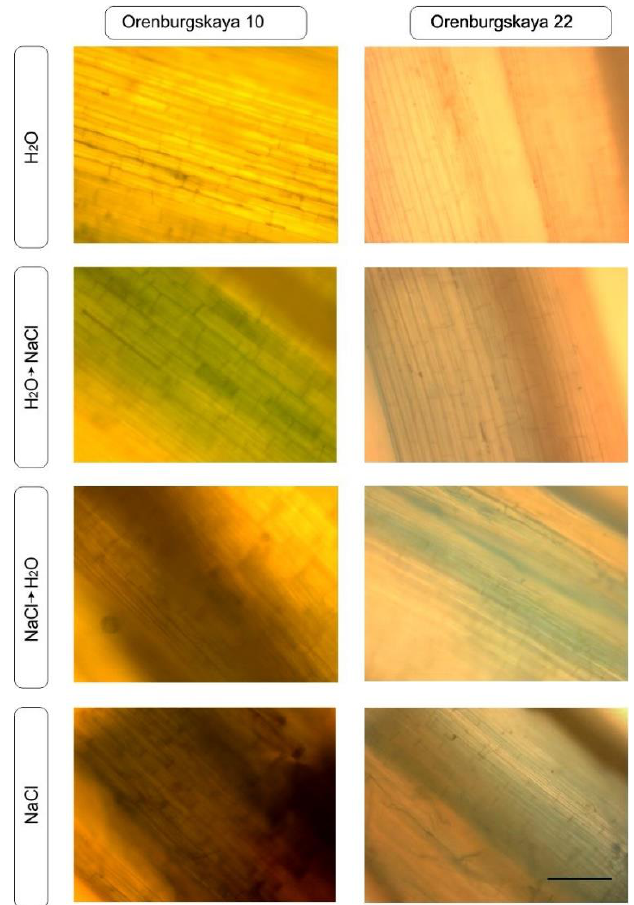
Figure 4. Trypan blue staining of coleoptile in 10-day-old seedlings differ in the number of dead cells. Scale segment: 400 microns.